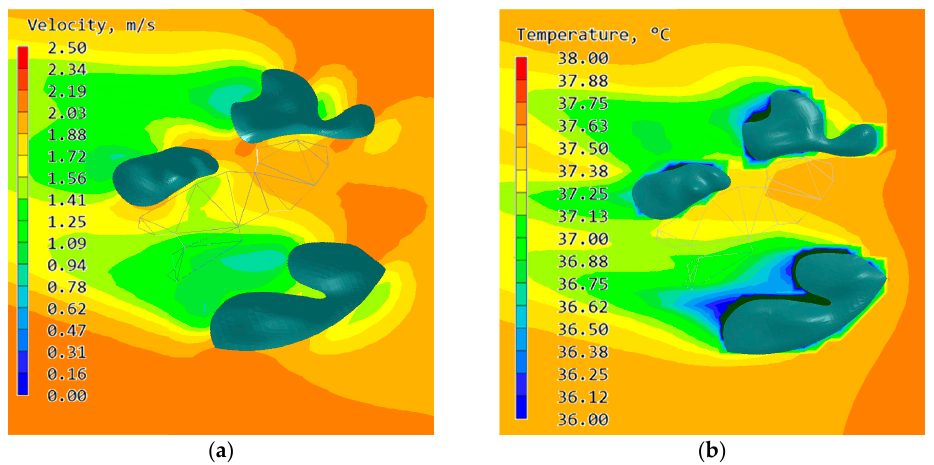
Figure 5. ( a ) Simulation of the summer wind environment in Zhuqiao village; ( b ) Simulation of the summer thermal environment in Zhuqiao village.